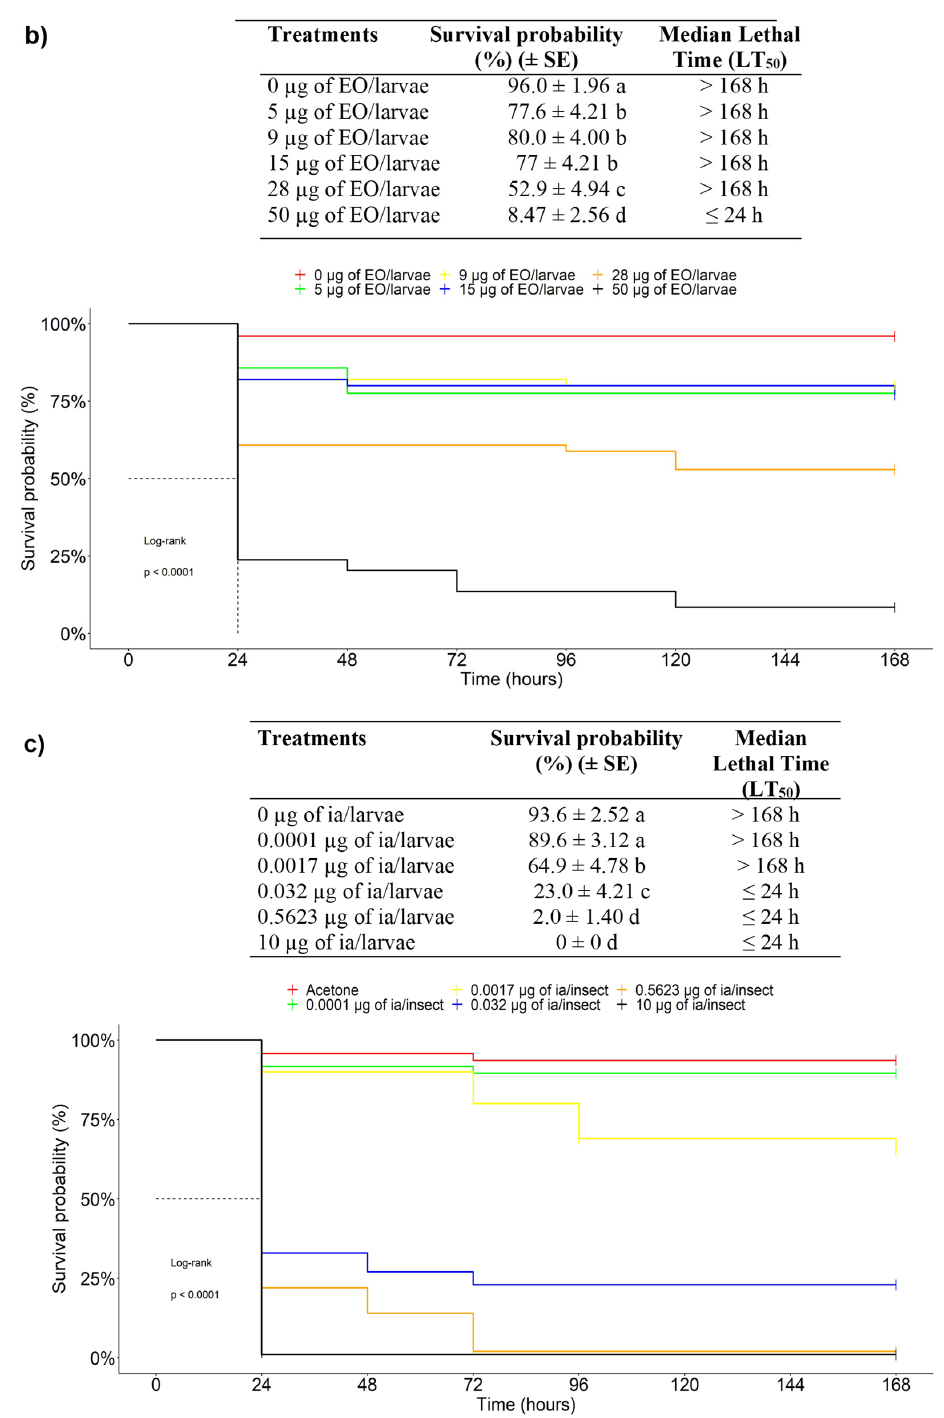
Figure 3. Survival analysis of caterpillars of Spodoptera frugiperda subjected to topical application of essential oil of Duguetia lanceolata (stem barks) ( a ); Duguetia lanceolata (leaves) ( b ); and the active ingredient cypermethrin ( c ). The same letters do not differ statistically by Pairwise multiple comparison test.